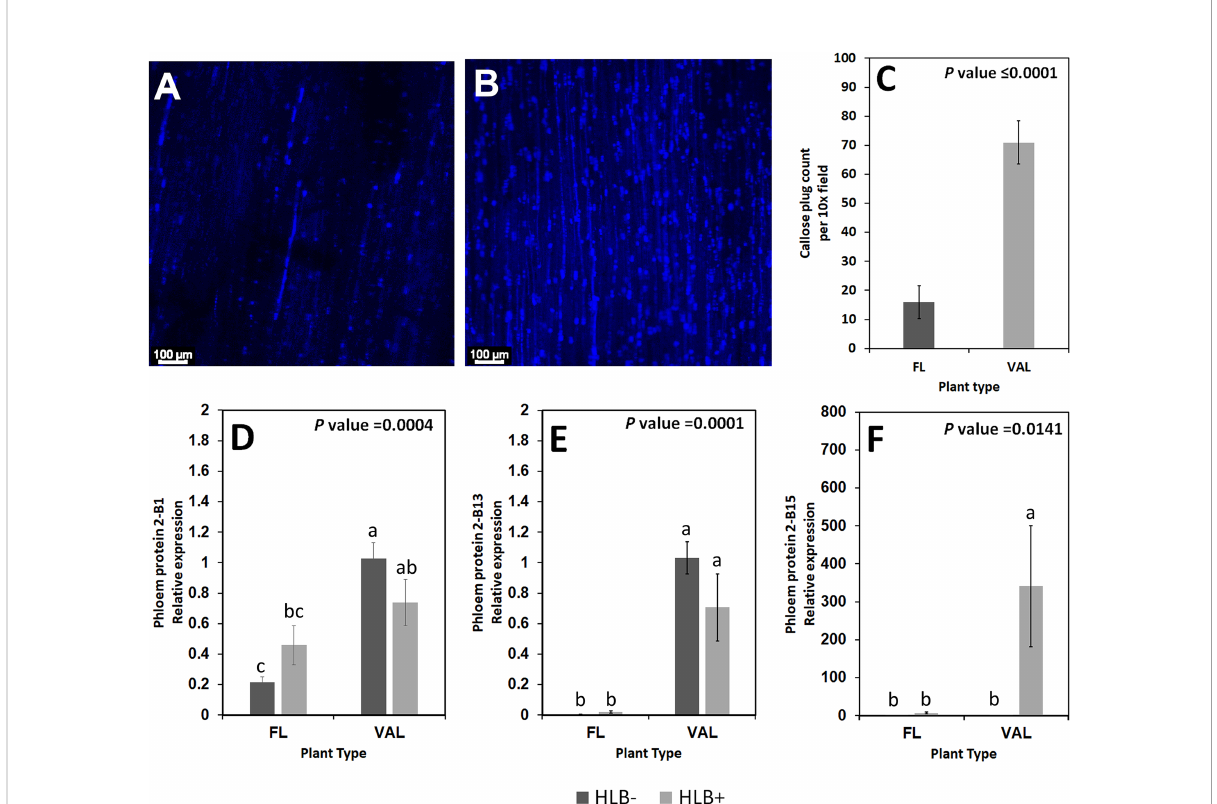
FIGURE 8 Non-zero counts of callose plugs per 10x fi eld image of the stem phloem of Ca Las+ Finger lime (A) and ‘ Valencia ’ sweet orange (B) sampled after 2 years following infection. The mean callose formation count per 10x fi eld image was signi fi cant. (C) Relative transcript levels of phloem proteins are calculated by real-time PCR and compared with the Ca Las free ‘ Valencia ’ . The Ca Las infected samples were collected from fi ve year old trees growing in the fi eld and the Ca Las free (control) samples were collected from trees kept in a protected greenhouse. The control trees were con fi rmed negative for Ca Las before further comparison. Data are means±SE of twelve samples (D – F) . Different letters above the error bar indicate statistically signi fi cant differences, while the same letters signify no signi fi cant differences using the Tukey-Kramer honestly signi fi cant difference test (Tukey HSD; p